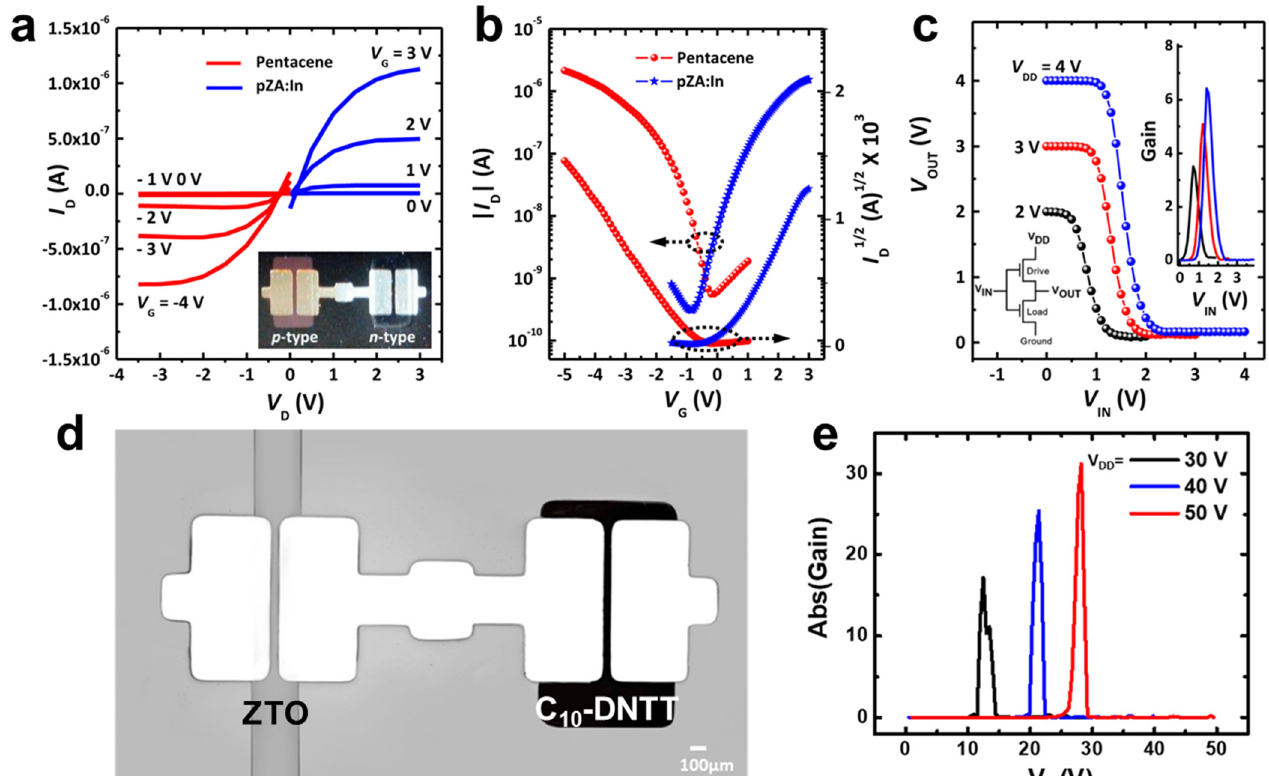
Figure 3. ( a ) Transfer characteristics of ZnO TFTs depending on indium doping. ( b ) Transfer characteristics and ( c ) output voltage characteristics of the pentacene and pZA:In-ZnO TFTs (adapted from [46] with permission from the American Chemical Society). ( d ) Top view OM image of a hybrid inverter comprising a printed ZTO transistor and a C 10 -DNTT transistor. ( e ) The voltage gains in the CMOS hybrid inverter under three V DD conditions ( V DD = 30, 40, and 50 V) (adapted from [92] with permission from MDPI).